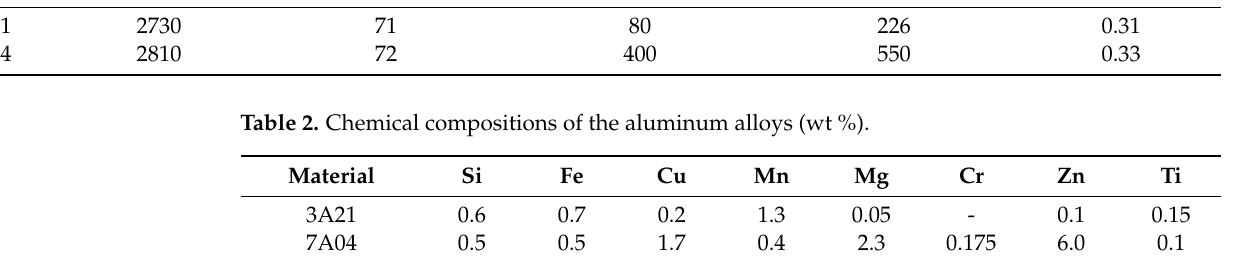
Figure 6. Photograph of the experiment layout. Table 1. Primary mechanical property parameters of materials.